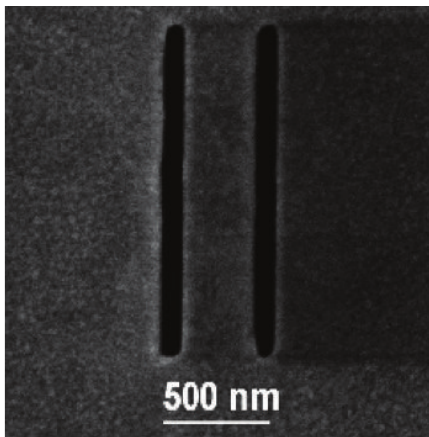
Figure 33: The nanometric slits.